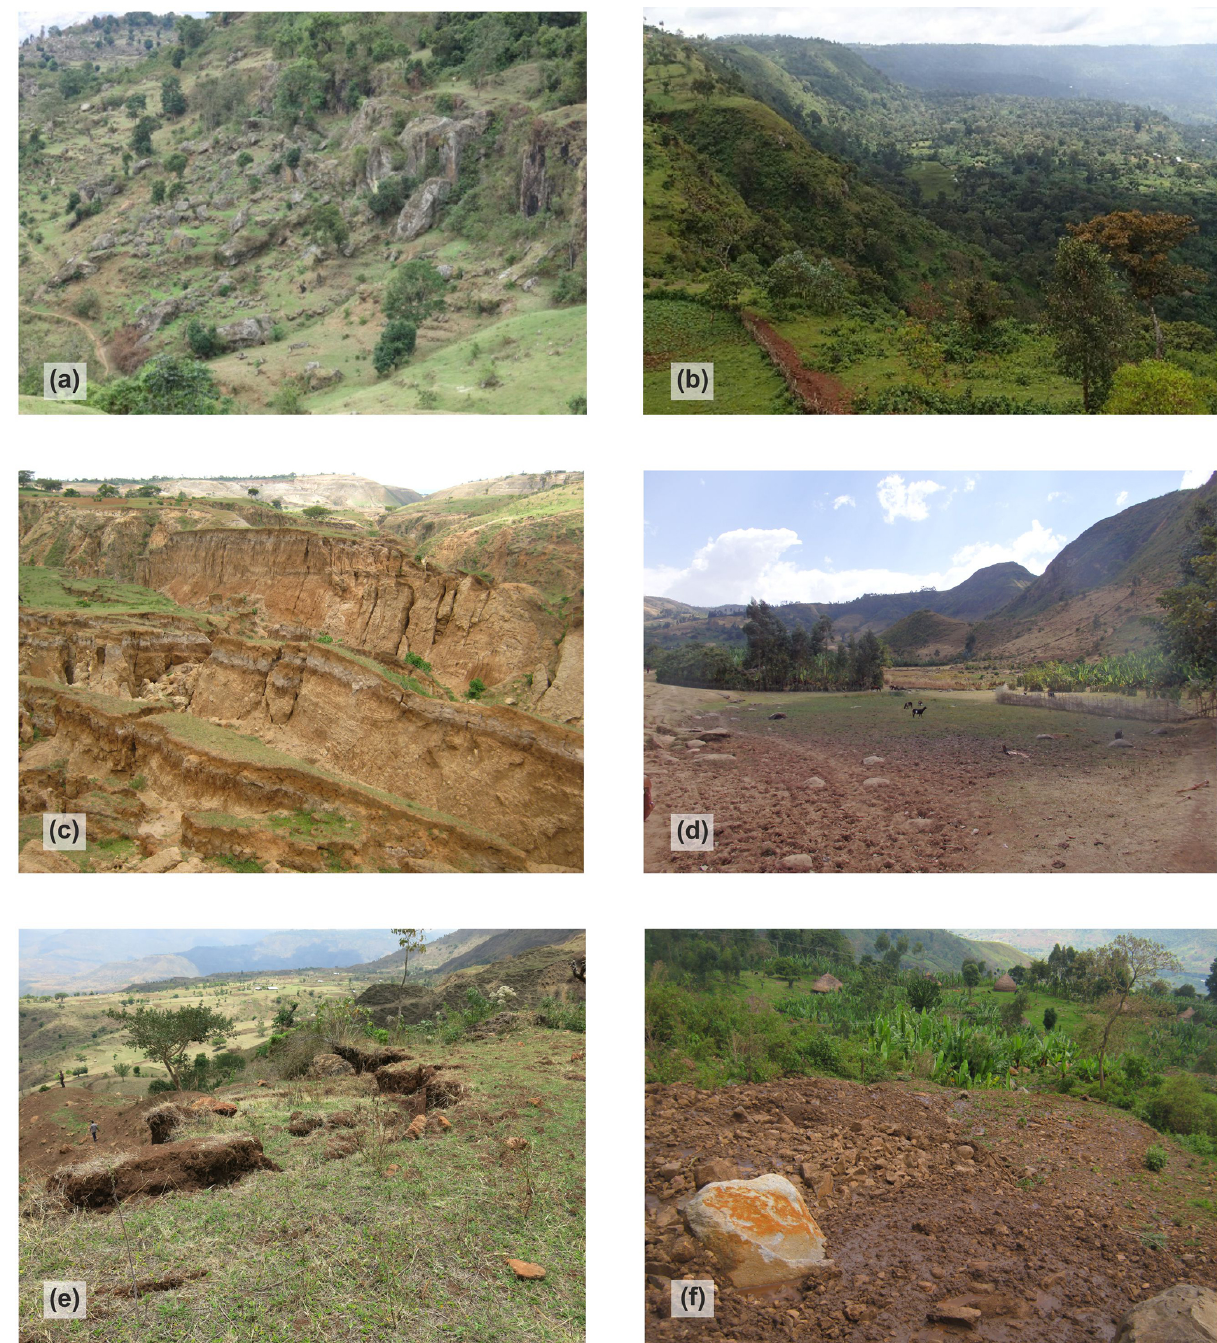
Figure 7. Field photographs of various types of geohazards in MER (Hossana and Dilla areas). (a) Toppling and subsequent rockfall of welded ignimbrites in the crown of a deep-seated landslide situated close to a fault scarp in the western highland area (Dilla area; NW of Arba Minch). (b) Large landslide in Dilla area (5km SW of Mejo). (c) Tilted blocks of deep-seated landslide southwest of Awassa. (d) Undrained depression in the deep-seated fossil landslide east of Dilla. (e) Tension cracks in the crown of a shallow landslide reactivated by road construction (west of Arba Minch). (f) Recent debris flow accumulation below the road construction in the landslide area west of